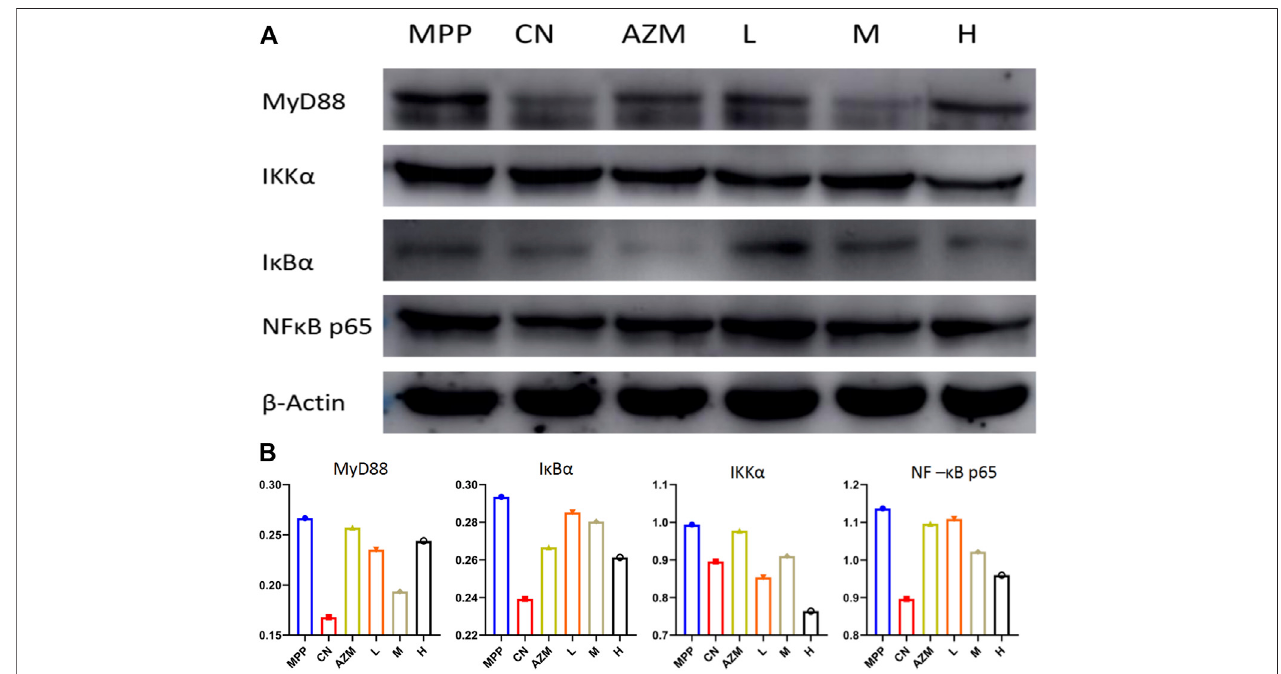
FIGURE 11 | (A) Western blot map of each histone. (B) Gray value of each